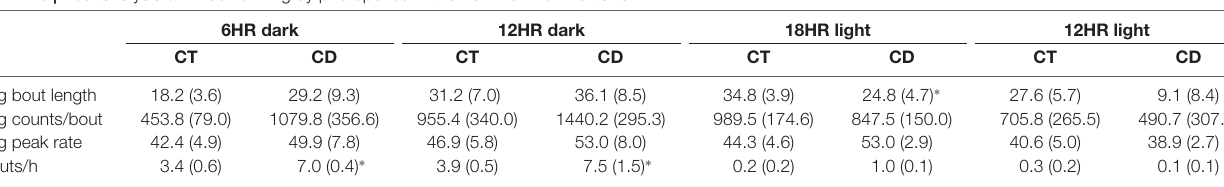
TABLE 3 | Bout analysis of wheel-running by photoperiod in the 18HR environmental